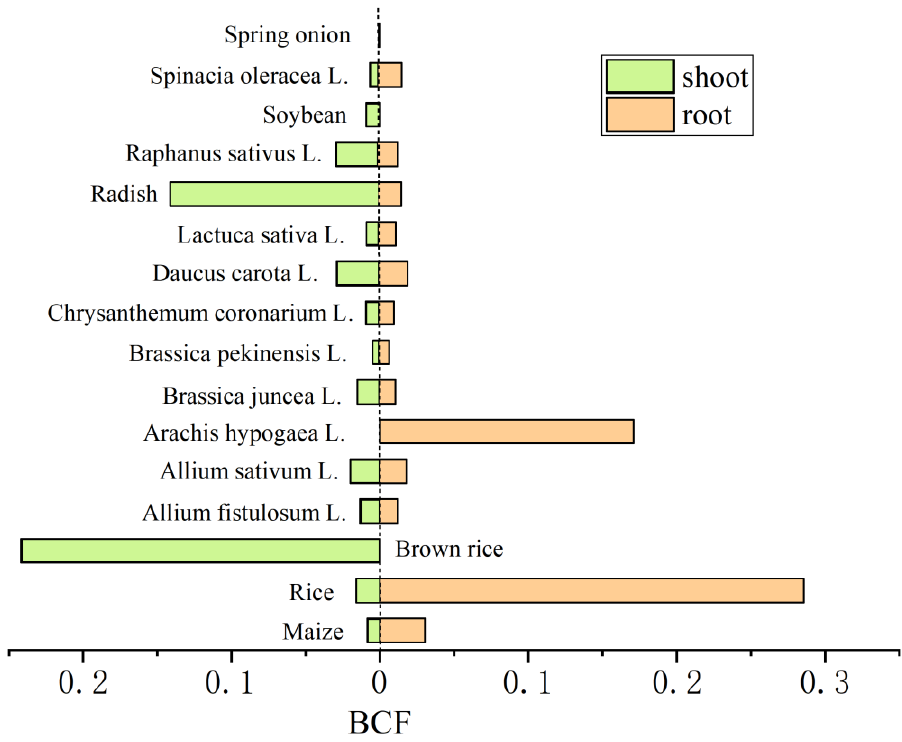
Figure 8. The ratio between the concentration of Sb in the root/shoot of crops and that present in the soil.